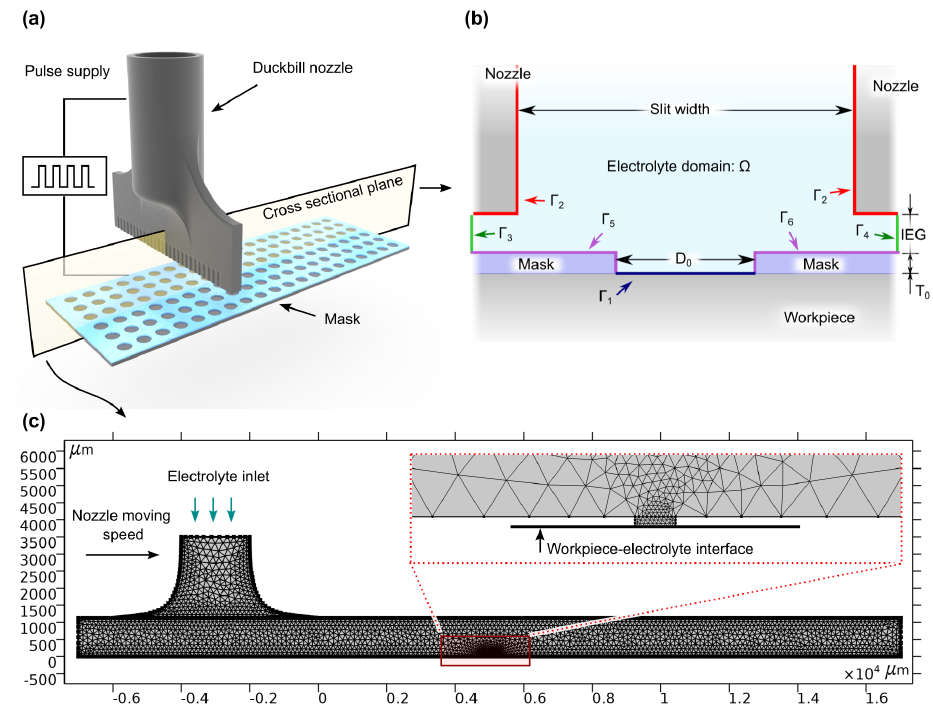
Figure 1. ( a ) MEJM process schematic view (not to scale). In this work, the lithographic mask array holes are 5 µ m in diameter. The center − to − center distance of these micro − holes is 50 µ m, and they are distributed as several 35 × 35 square arrays; ( b ) The 2D model diagram of MEJM (not to scale); ( c ) FEM simulation geometry and mesh.